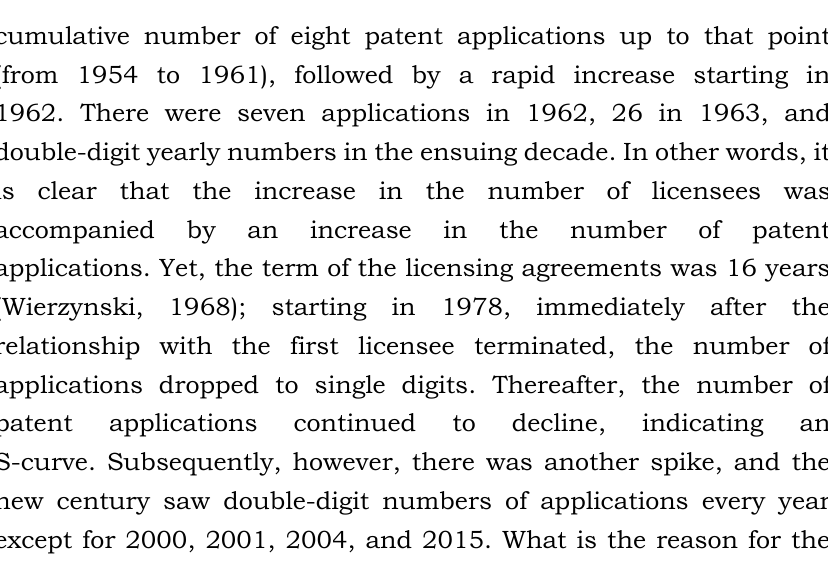
Figure 1. Patent applications for float process Source: Created by author from J-PlatPat search